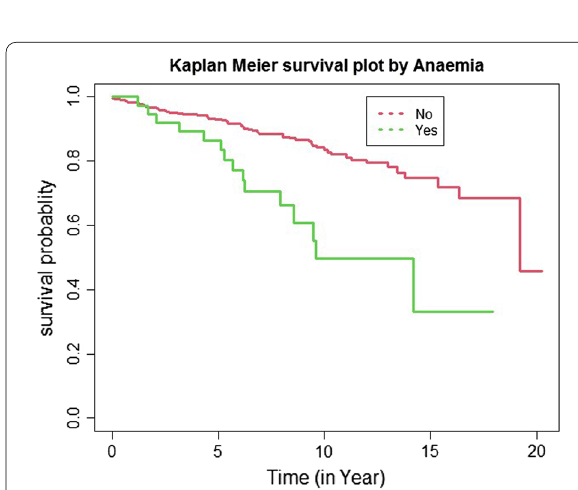
Fig. 2 Kaplan–Meier survival estimate show that the hazards of developing diabetic neuropathy were higher among patients who had anemia as compared to its counterparts. Green line show T2DM patients having anemia and red line those patients with no anaemia